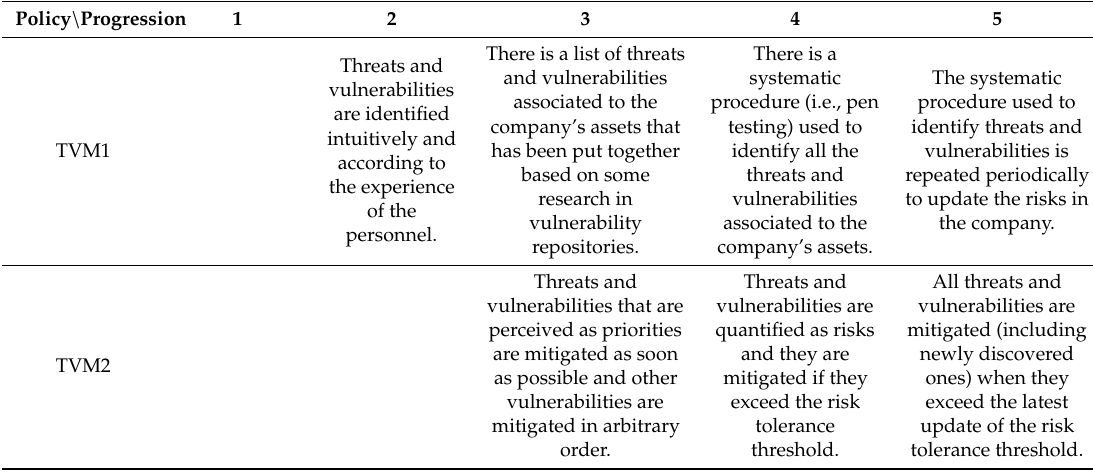
Table 13. Threat and vulnerability management policies’ progression model.